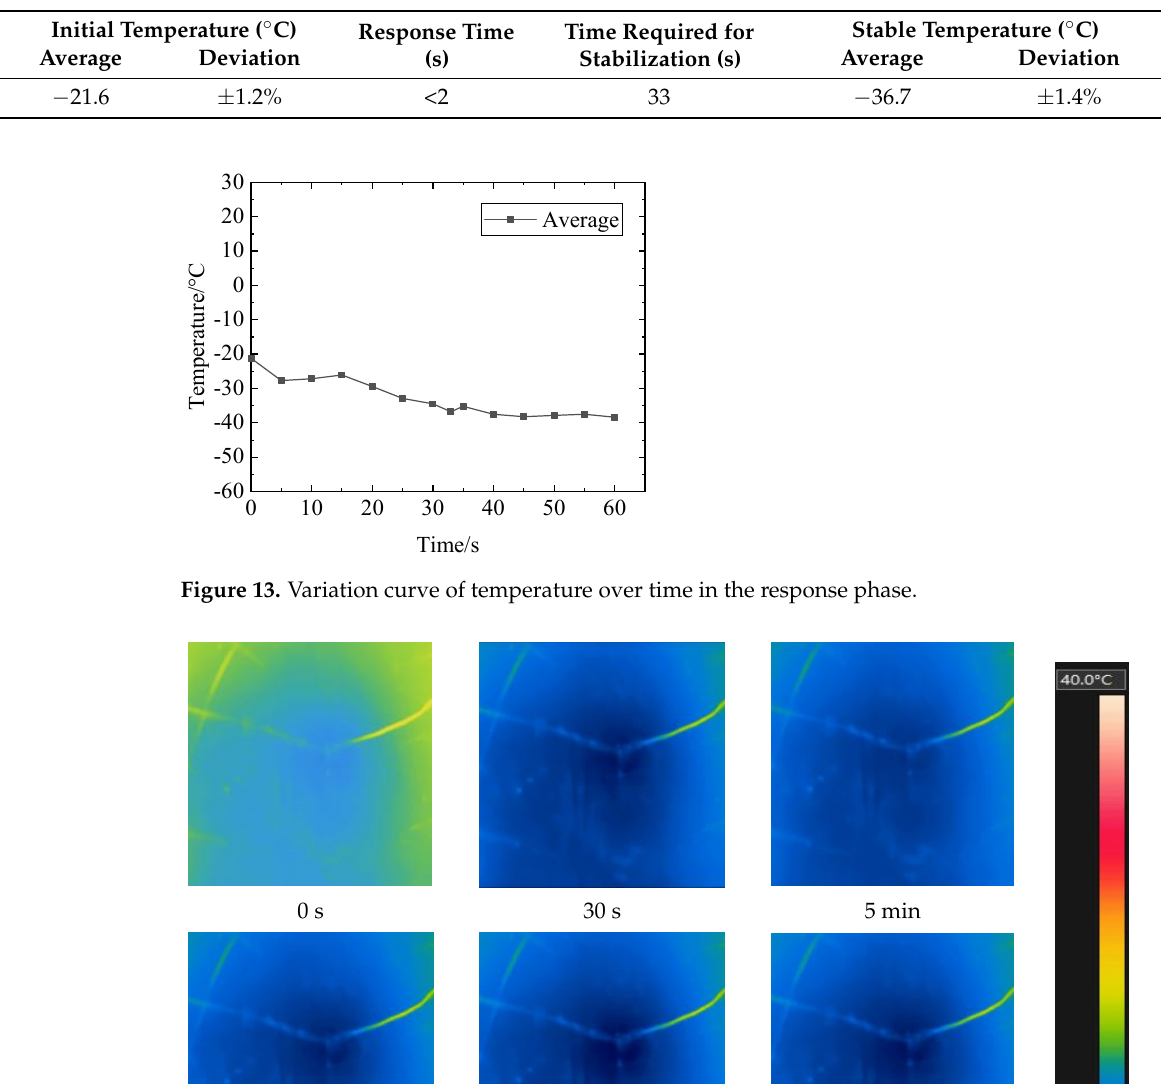
① Figure 15. Change curve of temperature over time with the decrease of 40 K under 6200 W/m 2 heat flux.